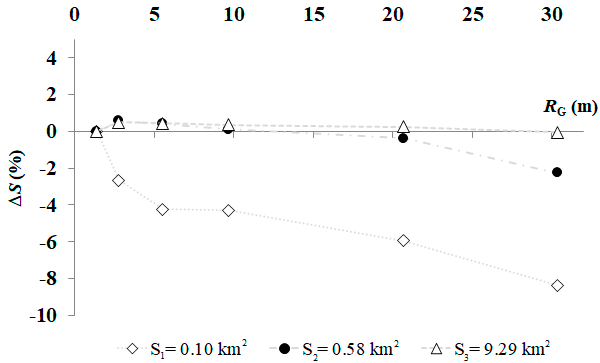
Figure 5. Δ S at varying R G over different lake sizes. Figure 5. ∆ S at varying R G over different lake